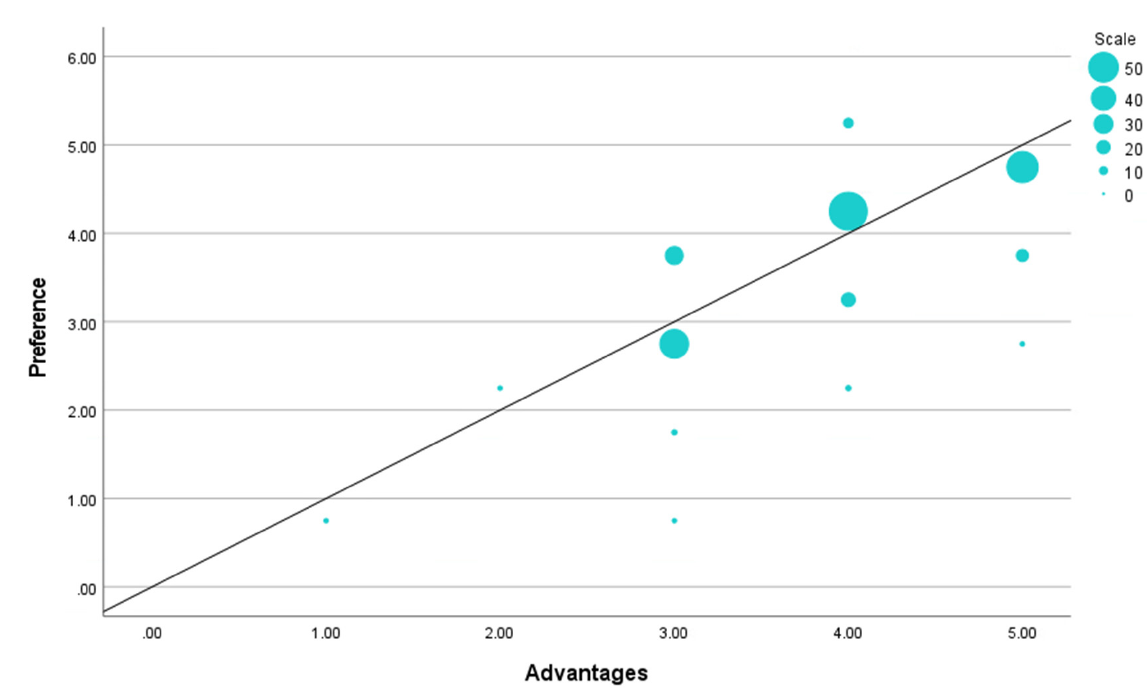
Figure 4. Relationship between Preference and Advantages.